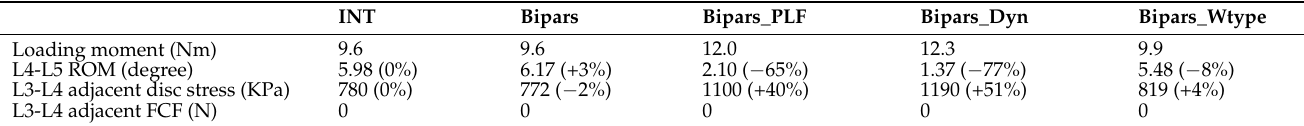
Table 2. ROMs, adjacent disc stress, and adjacent FCF in flexion.